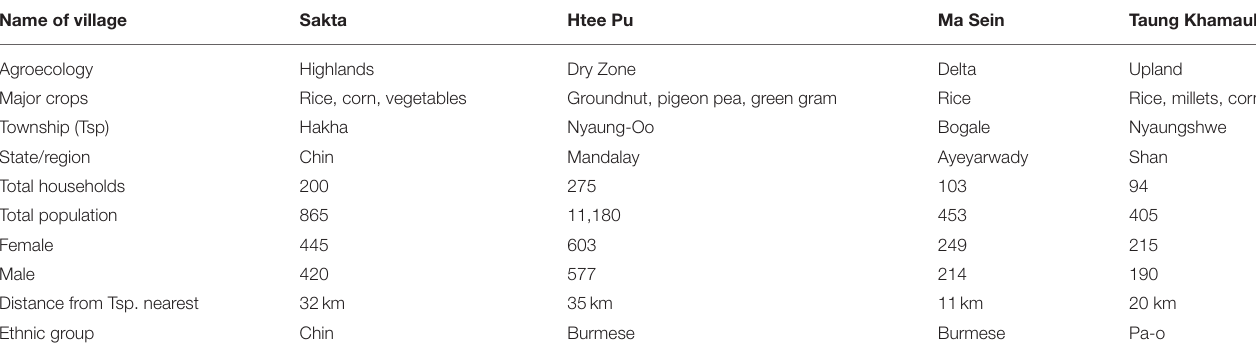
TABLE 2 | Profile of the Myanmar climate-smart